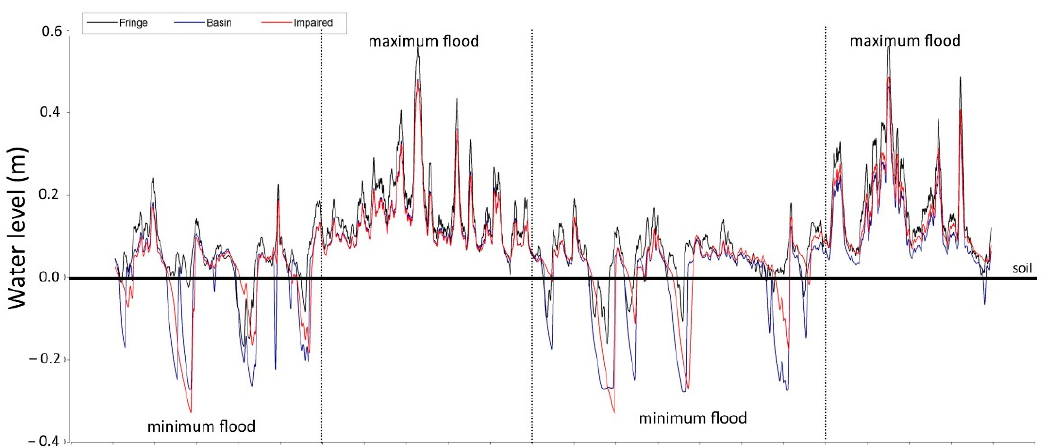
Figure 2. Time series of water levels on the fringe, basin, and impaired basin, from April 2016 to December 2017. Periods by segments of the maximum and minimum floods or water levels are in ‐ dicated.